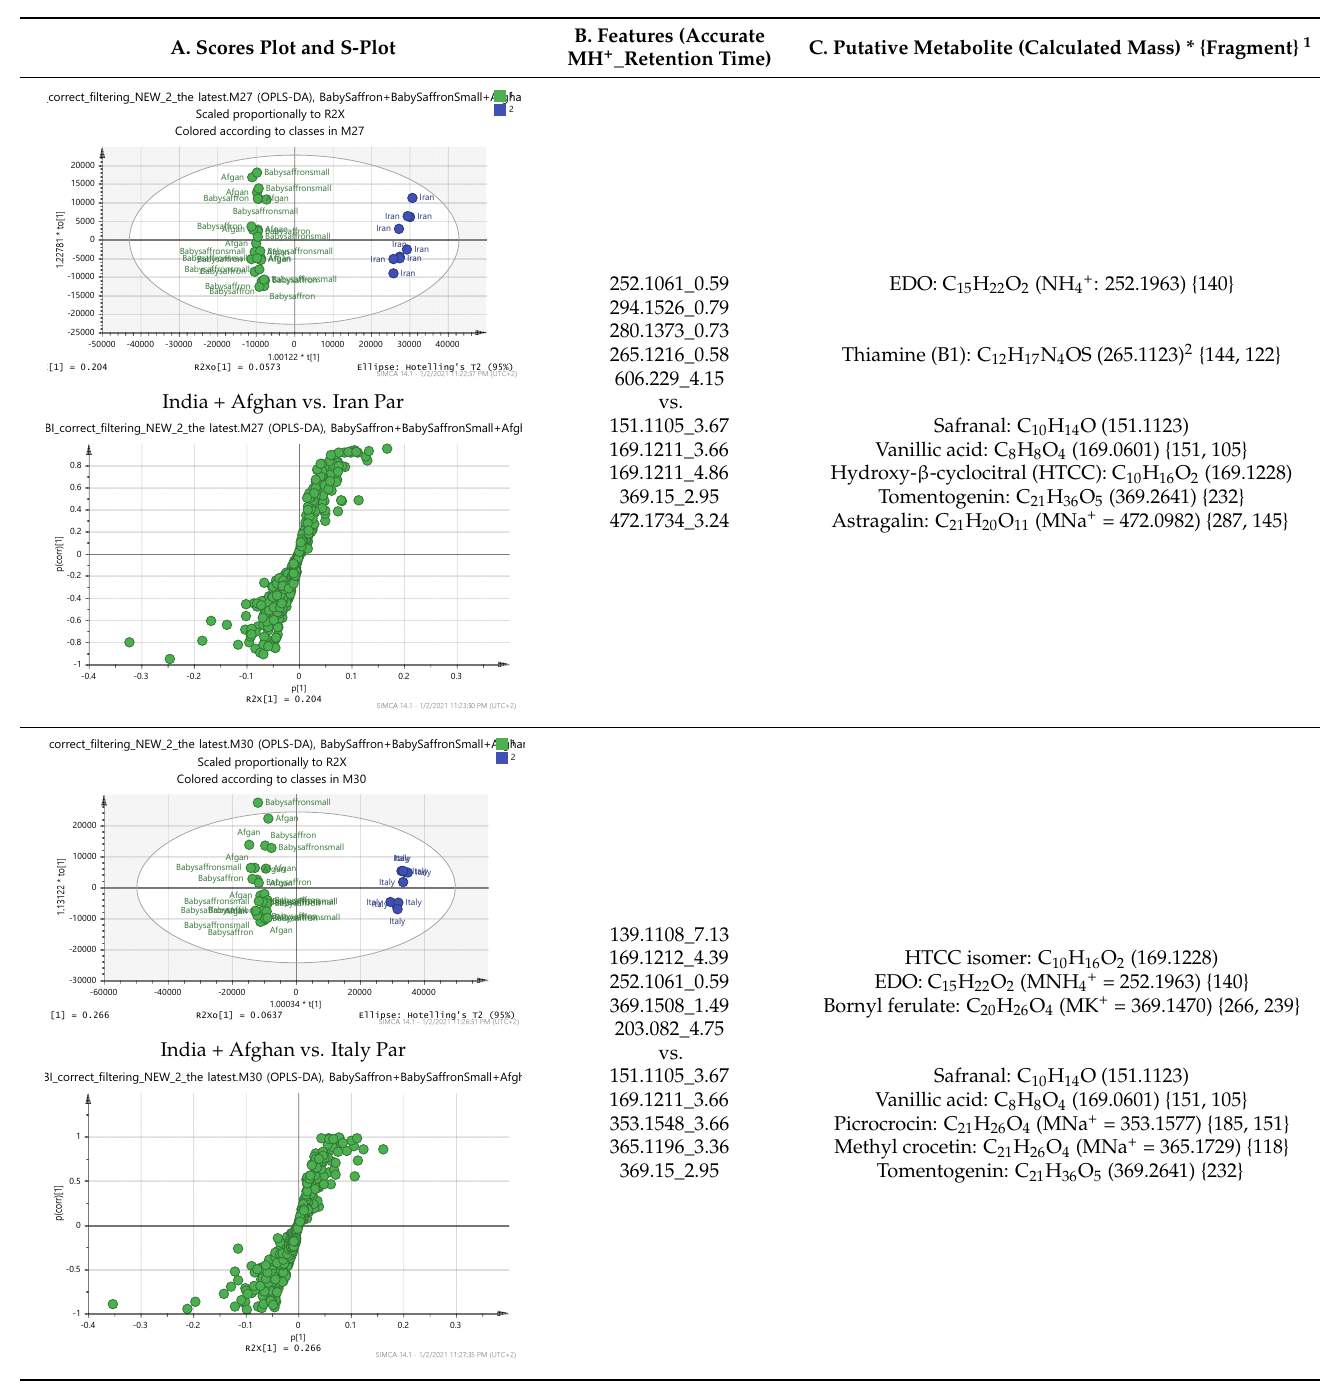
Colored according to classes in M33